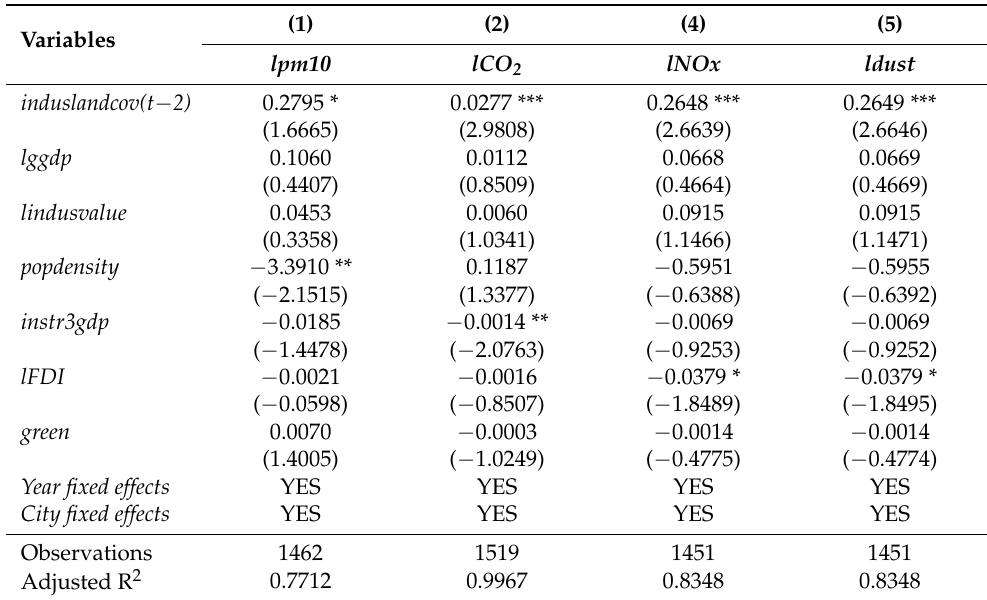
Table 4. Robustness